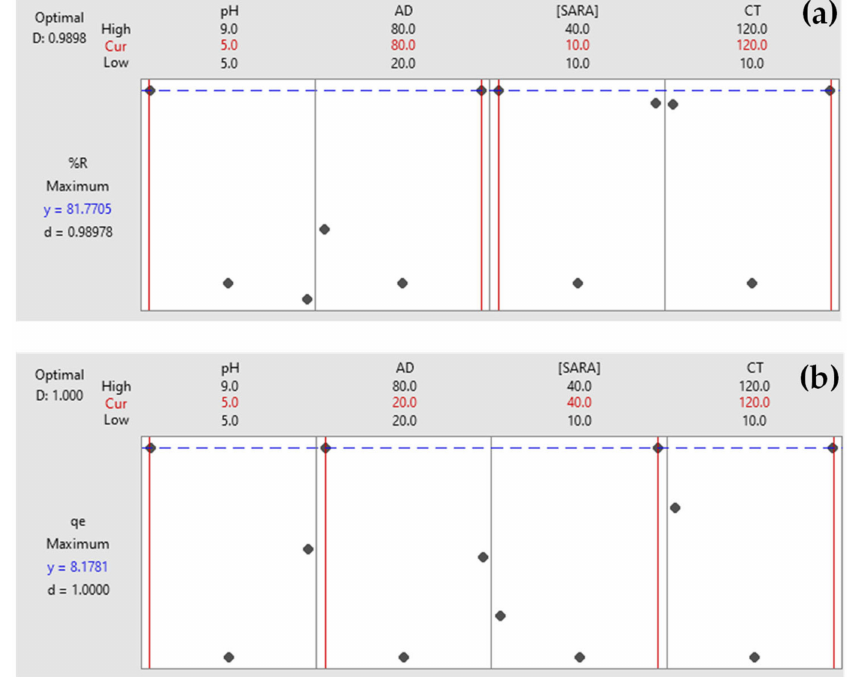
Figure 4. Optimization plots for ( a ) %R and ( b ) q e using